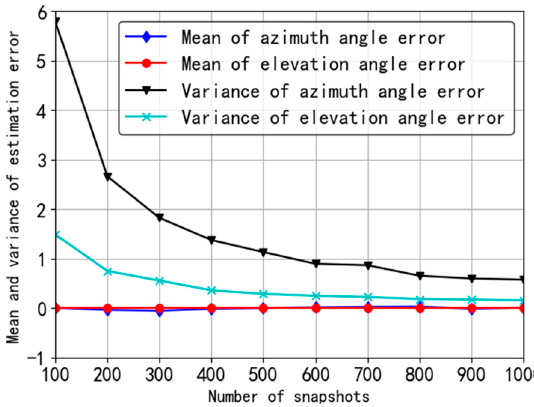
Figure 4. Simulation of angle estimation error.